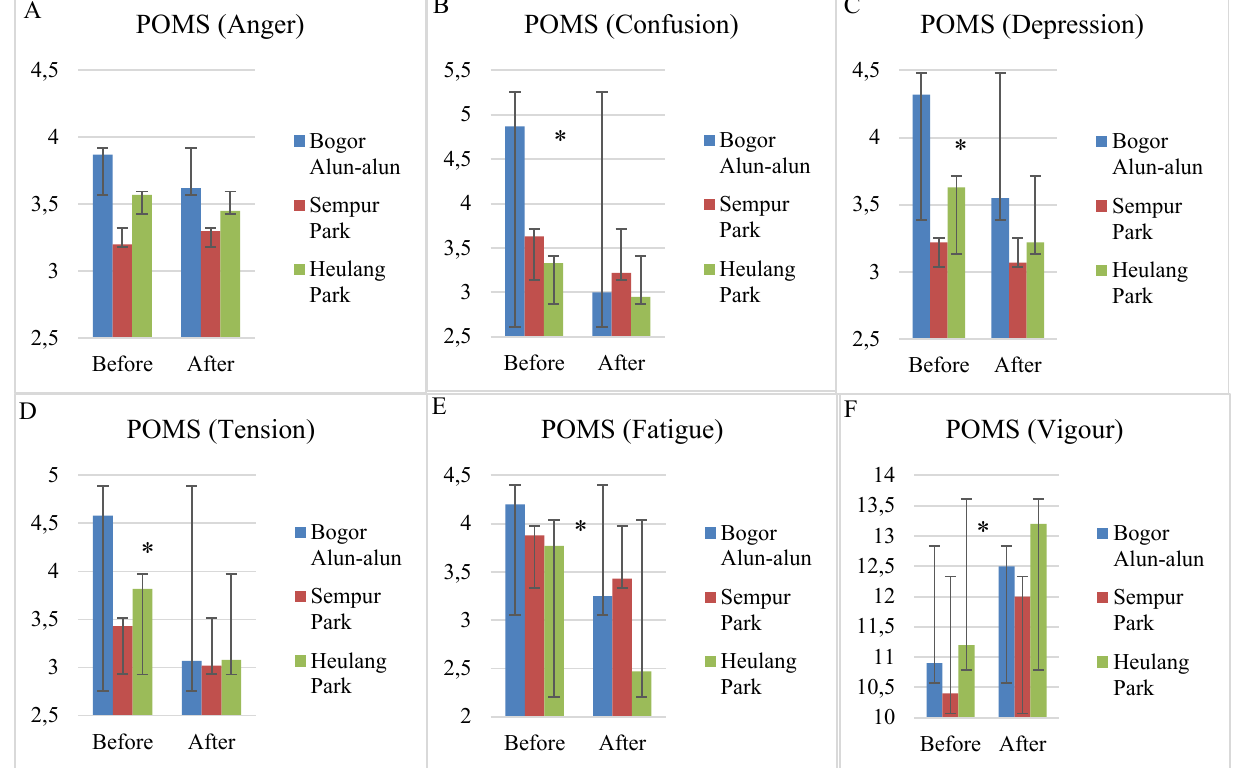
Figure 5. Comparison of the POMS subscale results before and after relaxed sitting experiment in the three locations. (A) Anger. (B) Confusion. (C) Depression. (D) Tension. (E) Fatigue. (F) Vigour. Note: (*) p - value ≤0